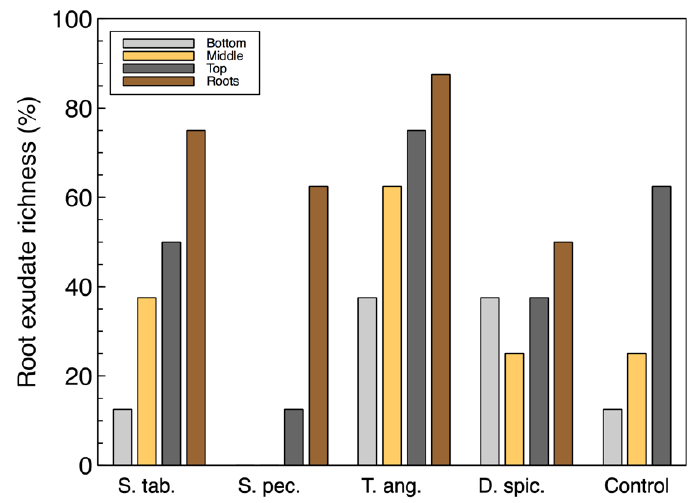
Figure 2. Microbial community richness of the biofilm samples based on the utilized carbon sources associated with plant root exudates.